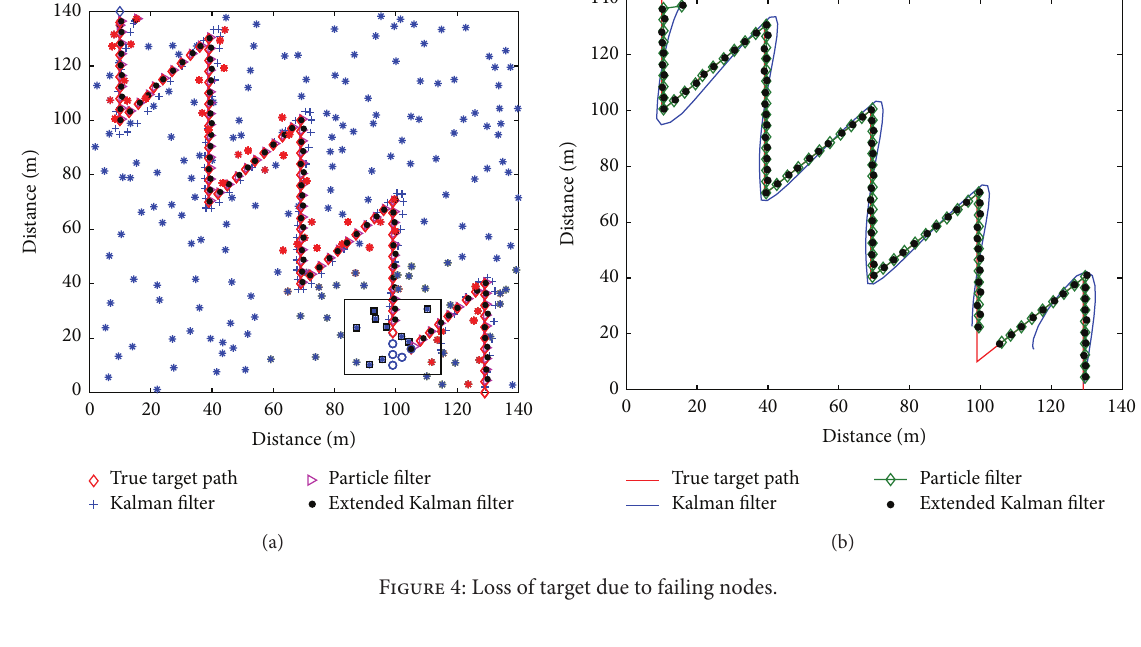
Figure 4: Loss of target due to failing nodes.